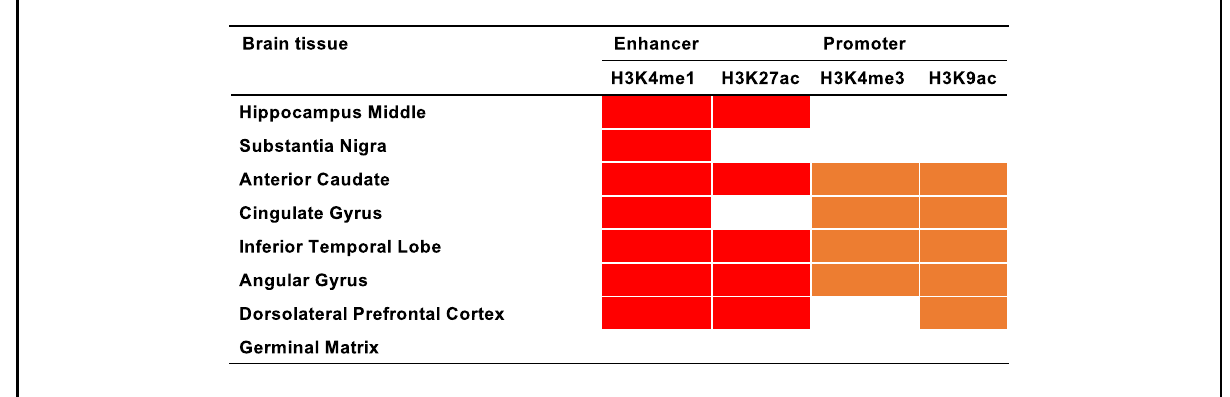
Fig. 3 Histone marks associated with enhancers or promoters in several brain regions on rs920608. Enhancers and promoters in eight brain